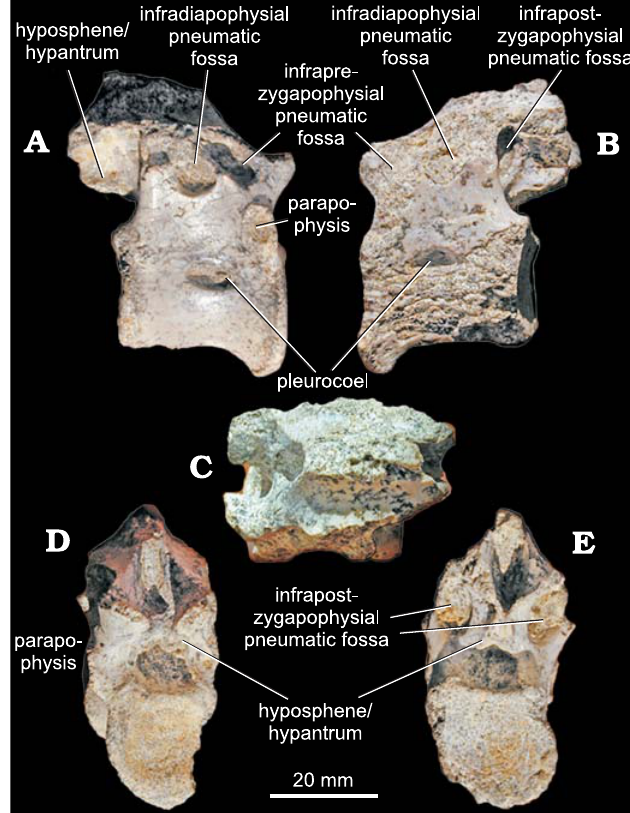
Fig. 2. Crested theropod dinosaur Elmisaurus rarus Osmólska, 1981, MPC-D 102/007 from Nemegt Formation (Upper Cretaceous), Western Sayr of Nemegt locality, Mongolia. Anterior dorsal vertebra in right lateral ( A ), left lateral ( B ), dorsal ( C ), anterior ( D ), and posterior ( E )